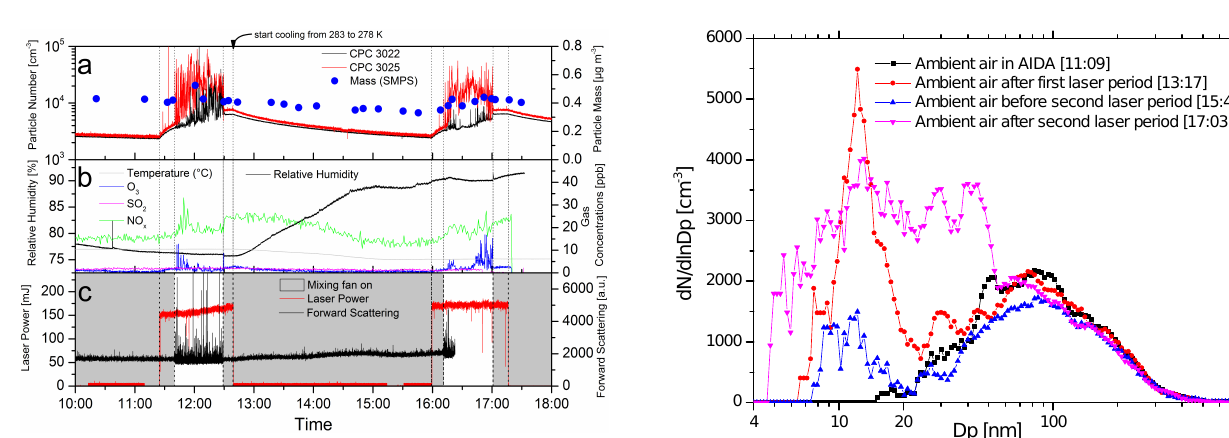
Fig. 12. Particle size distributions for selected times during the ex- periment with laser filaments in ambient air in the AIDA simula- tion chamber at 283.6K and ∼ 76% RH and 279K and ∼ 90% RH. Times in the legend correspond to Fig.